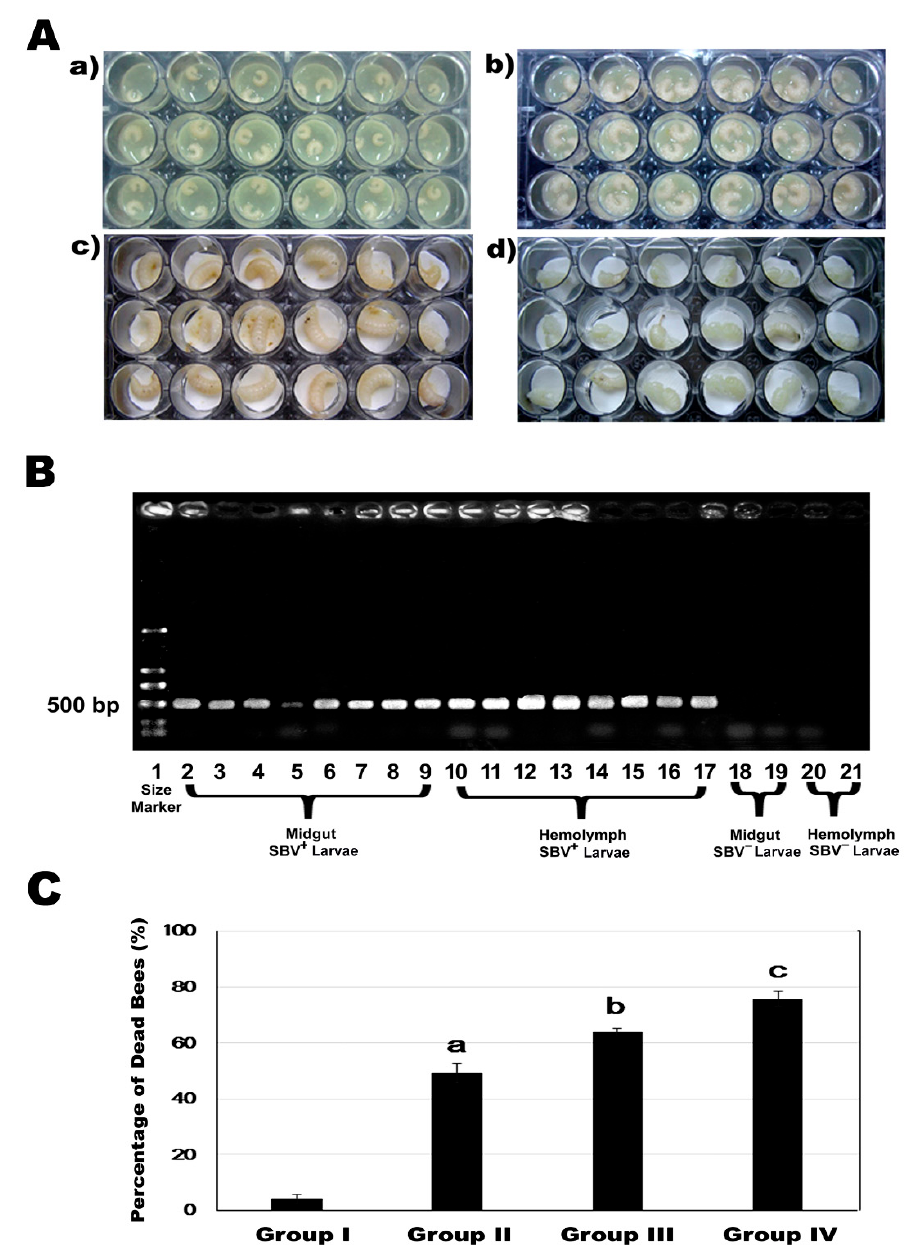
Figure 6. Effect of cold stress on SBV infection. ( A ) SBV infection in vivo. a) 2nd instar larvae (108 ± 3 h post laying), b) 3rd instar larvae, c) 4th instar larvae, and d) 5th instar larvae. ( B ) Detection of SBV by RT-PCR and gel electrophoresis. RNA was extracted from midgut and hemolymph of larvae after 24 h SBV inoculation and examined for the presence of SBV by RT-PCR method and electrophoresis. The number 1 indicates a size marker, numbers 2–9 indicate the midgut tissue of SBV-infected larvae, numbers 10–17 indicate the hemolymph of SBV-infected larvae, numbers 18–19 indicate the midgut tissue of uninfected larvae (negative control), and numbers 20–21 indicate the hemolymph of uninfected larvae (negative control). The size of PCR fragments is indicated on the left of the gel. ( C ) Larvae mortality for the cold challenge and pupation among the four experimental groups. Group I—negative control without SBV infection or cold challenge, Group II—group with SBV infection but without cold challenge, Group III—group with SBV infection and cold challenged at the 2nd instar larvae, and Group IV—group with SBV infection and cold challenged at the 5th instar larvae. Different letters on the top of individual bars indicate significant differences ( p ≤